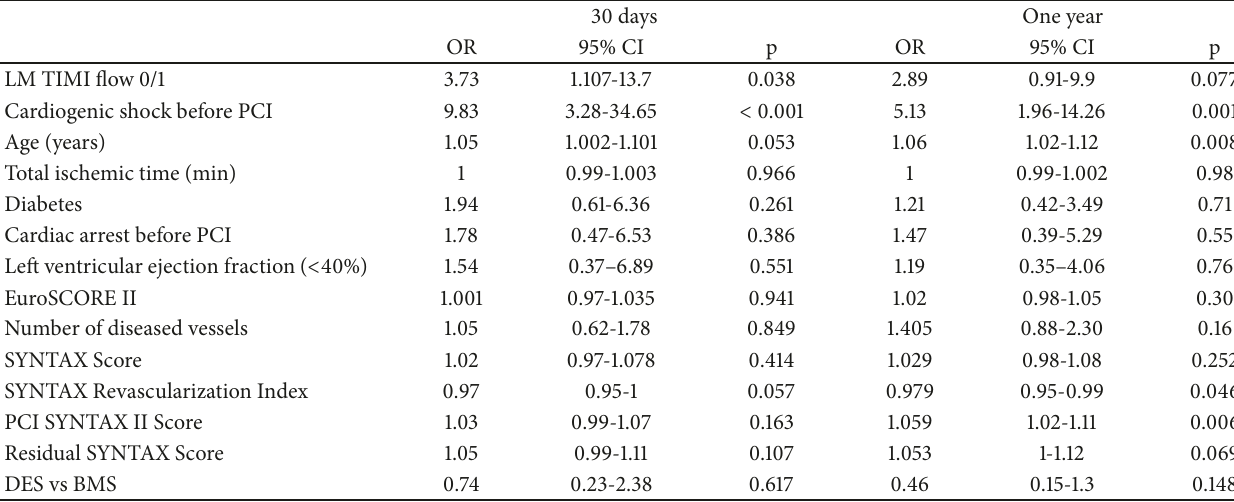
Table 4: Multivariate logistic regression for the prediction of 30 days and 1-year all-cause mortality (adjusted for cardiogenic shock and TIMI flow). BMS = bare-metal stent, DES = drug-eluting stent, LM = Left Main, PCI = percutaneous coronary intervention, and TIMI = Thrombolysis in Myocardial Infarction.